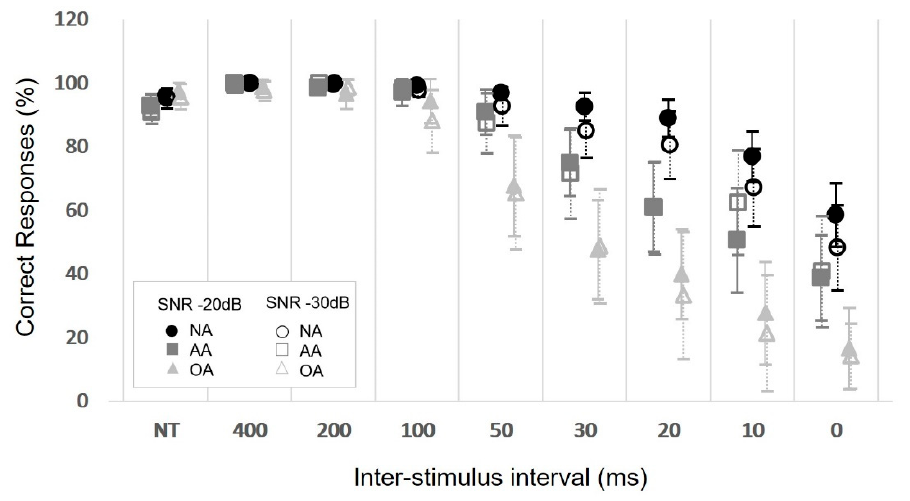
Figure 2. Distribution of the average number of correct responses per interstimulus interval for both SNRs in both ears for the three groups. SNR: signal-to-noise ratio; NA: normal adults group; AA: abnormal adults group; OA: older adults group; NT: no-tone. Error bar = 95% confidence interval.